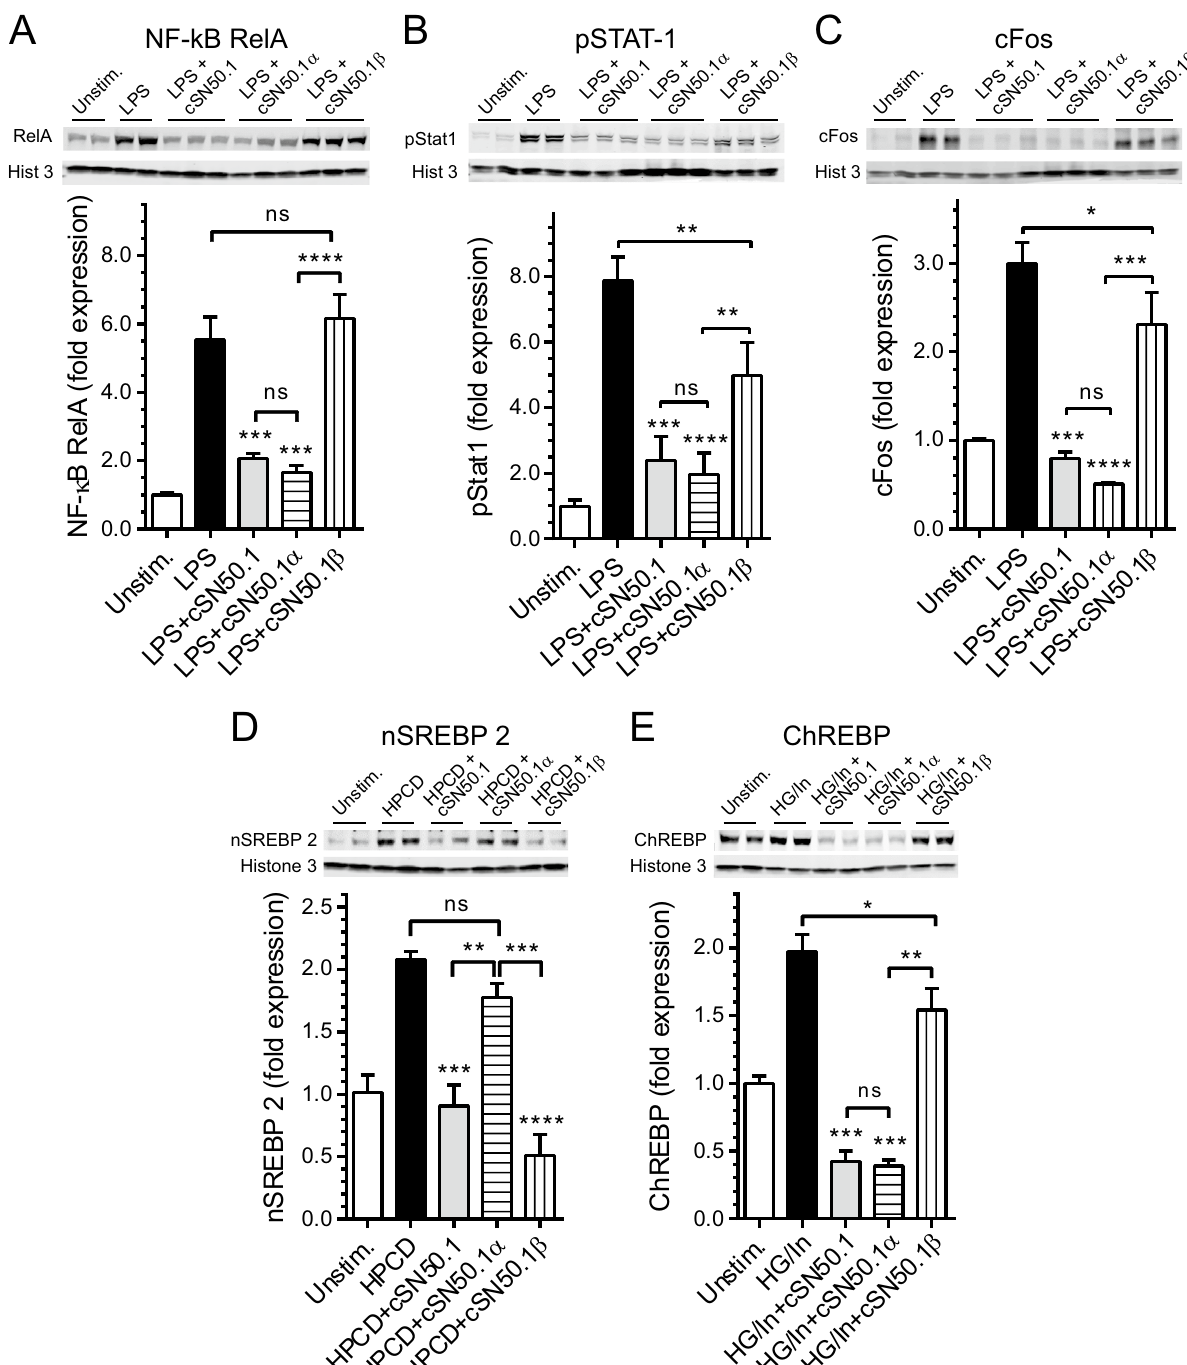
Figure 2. Differential effect of pathway-selective NTM peptides in cultured cells. ( A–C ) Treatment with Imp α5-selective NTM, cSN50.1α inhibits nuclear import of SRTFs: NF-κB RelA ( A ), phosphorylated STAT1 ( B ), and component of AP-1 complex, cFos ( C ) in LPS-stimulated RAW cells. Cells were pretreated with 30 µM NTM peptides (biselective cSN50.1, and two monoselective cSN50.1α and cSN50.1β) for 30 min then incubated with LPS (10 ng/mL) for 6 h. ( D ) Nuclear import of nSREBP2 is inhibited by treatment with Imp β1-selective NTM, cSN50.1β peptide, in sterol-depleted HEK 293T cells. Cells were rapidly depleted of sterols by 15 min incubation with hydroxypropyl-beta-cyclodextrin (HPCD) and treated with NTM peptides (as indicated) for 2 h. ( E ) Metabolic transcription factor (MTF) ChREBP is transported to the nucleus primarily by Imp α5-mediated nuclear import pathway. HepG2 cells were incubated in low glucose (5.5 mM) medium for 24 h. Subsequently, they were treated with high glucose (HG, 25 mM) supplemented with 100 nM insulin (In) to facilitate intracellular influx of glucose. 30 µM NTMs (as indicated) were added and cells were incubated for additional 24 h. ( A ) through ( E ) nuclear content of SRTFs and MTFs was determined by quantitative immunoblotting analysis using LI-COR Odyssey infrared imaging system. Data is presented as a mean ± SEM (n = 4 for D , E ; n = 6 for A , B , C ). Statistical significance between LPS-stimulated cells (control) and NTM peptides-treated LPS-stimulated cells was determined by ordinary One-way ANOVA with Holm–Sidak test for multiple comparison, * p < 0.05, ** p < 0.005, *** p < 0.0005, **** p < 0.0001. Unedited full-length immunoblots are presented in Supplementary Figure